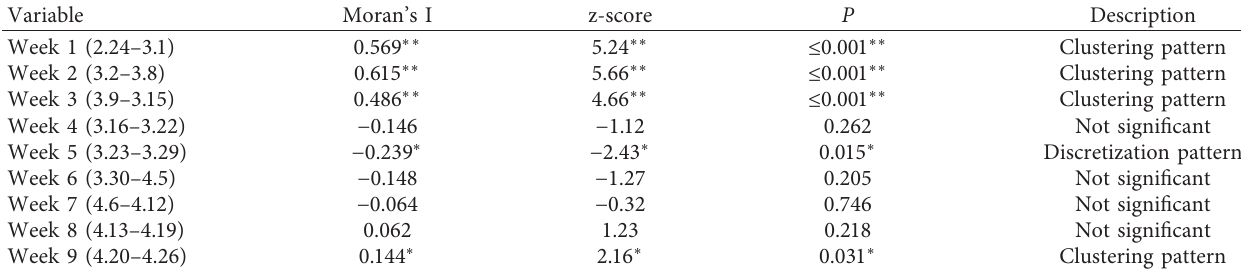
Table 7: Results of the global autocorrelation analysis of the in-city travel intensity.